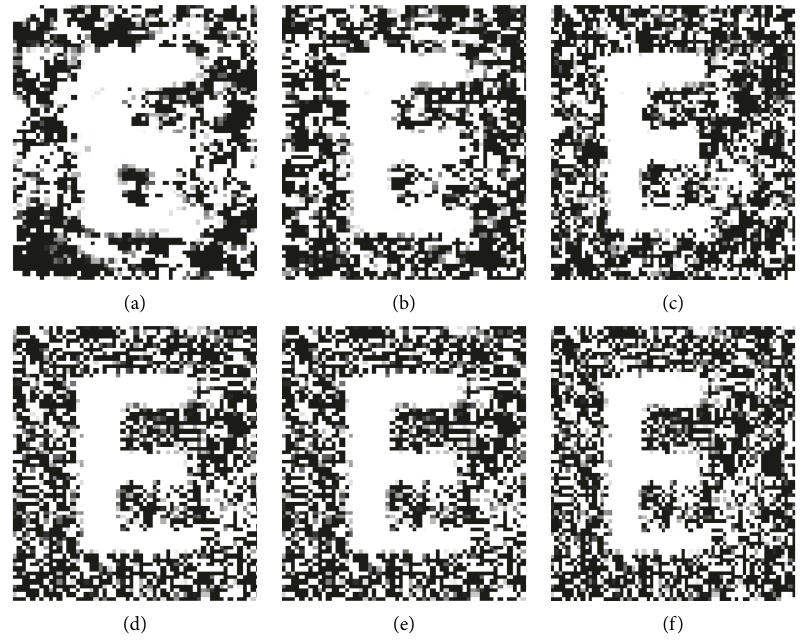
Figure 10: Phase distribution of the decrypted 2D object using correct keys: (a) 64 × 64 × 5% measurements; (b) 64 × 64 × 10% mea- surements; (c) 64 × 64 × 15% measurements; (d) 64 × 64 × 35% measurements; (e) 64 × 64 × 45% measurements; (f) 64 × 64 × 65% measurements.